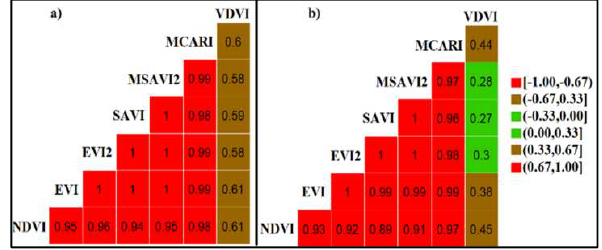
Figure 4: Correlation analysis of the vegetation indexes considering a) rainy season and b) dry season. Experiment 3 presented a slightly lower OA than experiment